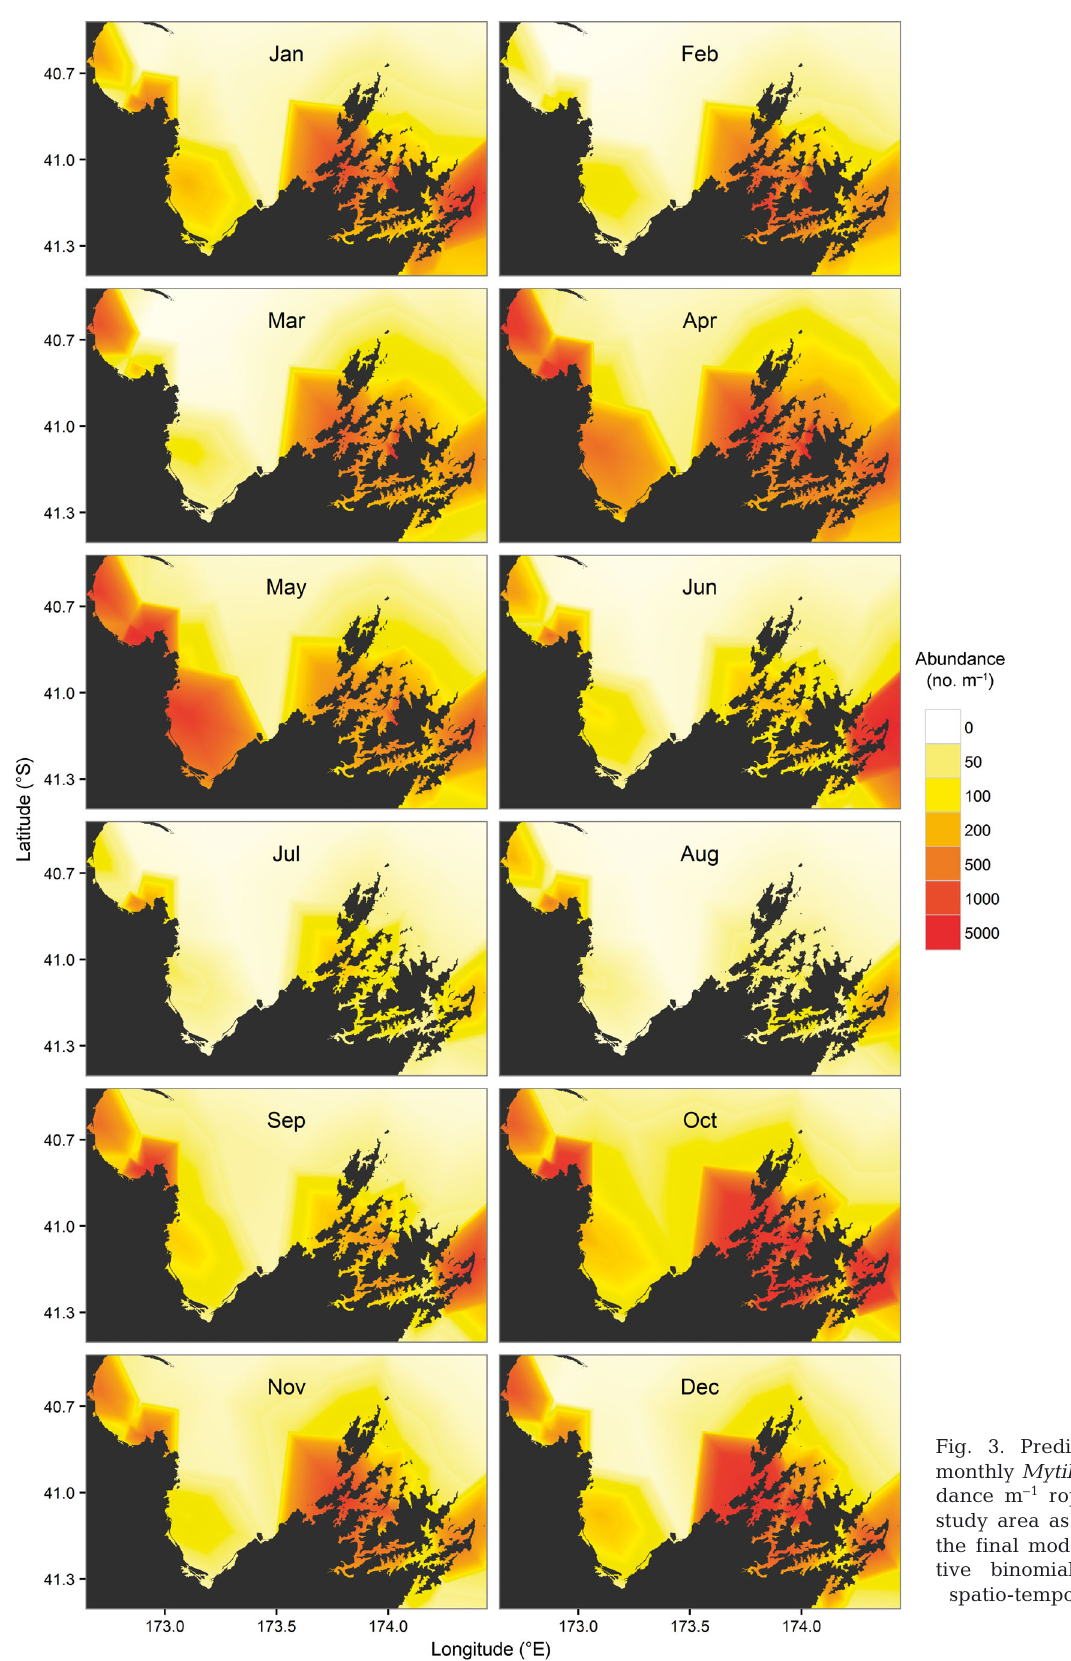
Fig. 3. Predicted average monthly Mytilus spat abun- dance m –1 rope across the study area as estimated by the final model with nega- tive binomial errors and spatio-temporal